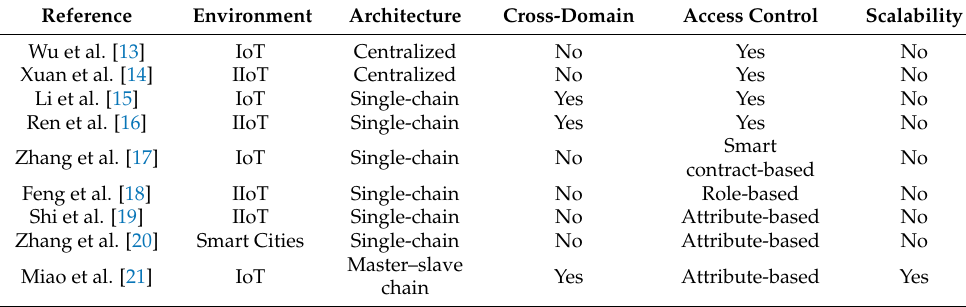
Table 1. A summary of the existing